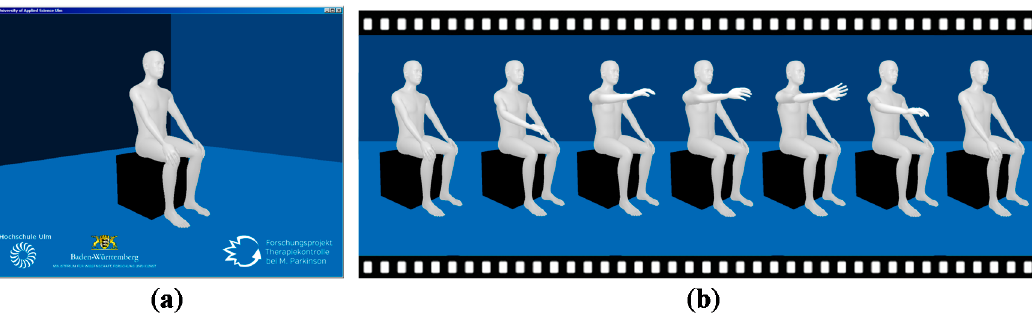
Figure 5. Implemented 3D avatar ( a ) Full screen view; ( b ) Pronation-supination movement sequence.